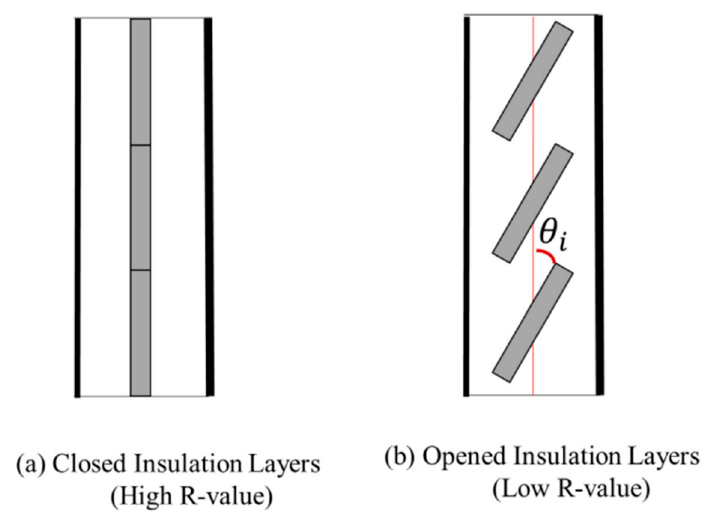
Figure 1. Mechanical switchable insulation system (SIS) prototype.